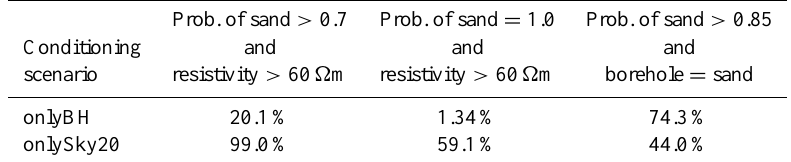
Table 1. Split sample test showing how many of the high-probability sand cells (resistivity > 60 (cid:127) m) are simulated with corresponding sand probabilities ( > 70%) or fully deterministic (probability = 1.0) among 25 realizations. Conditioned to onlyBH and onlySky20. The last column shows how many of the areas that are shown as sand in the boreholes are simulated with sand probabilities > 85%. Prob. of sand > 0.7